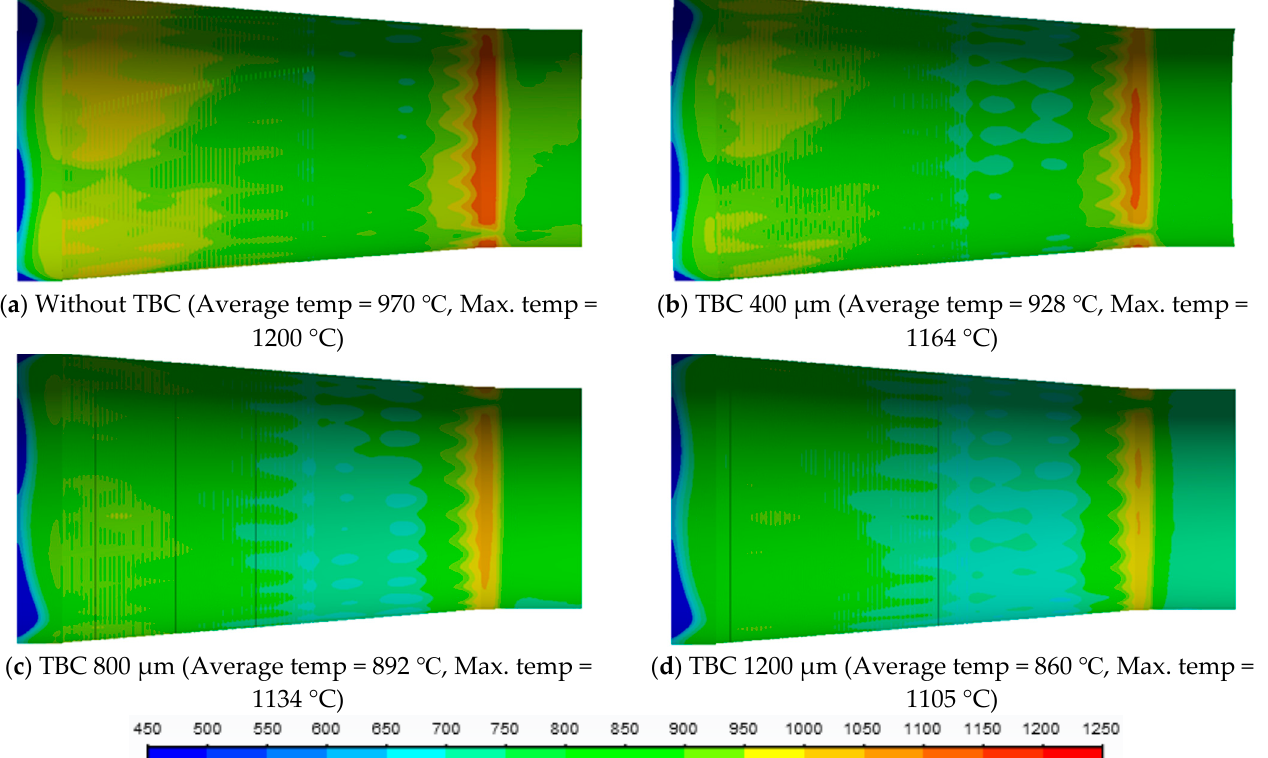
Figure 13. Outer CL metal surface temperature distribution (cooling side) based on the TBC thickness.